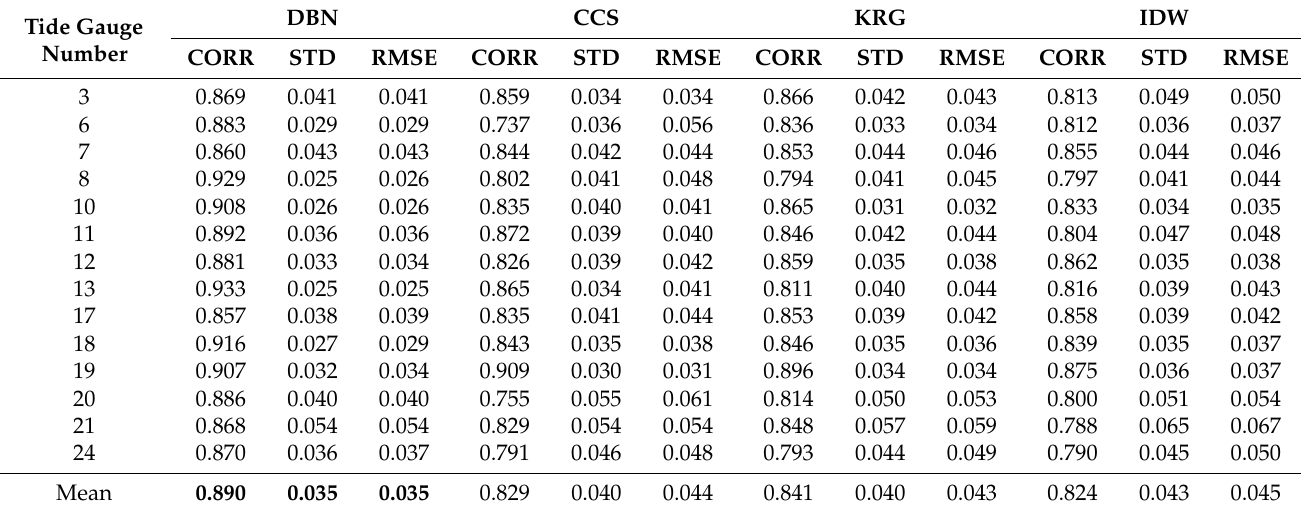
Table 2. Statistics of the four methods with altimetry-derived along-track SLAs in scheme (b) (m).